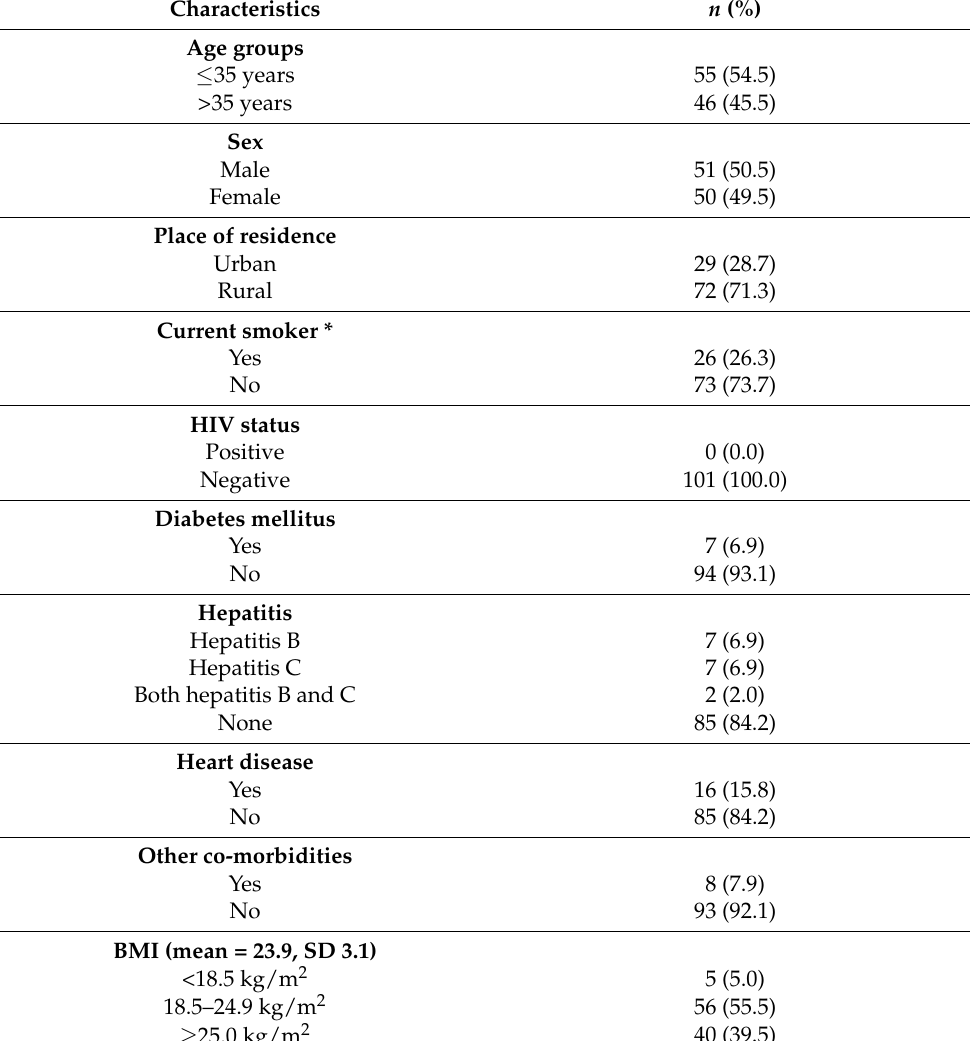
Table 1. Demographic, epidemiological, and clinical features of patients diagnosed with respiratory tuberculosis who underwent adjunctive surgery at RSSPMCPP in Uzbekistan from January to May 2017 ( n =